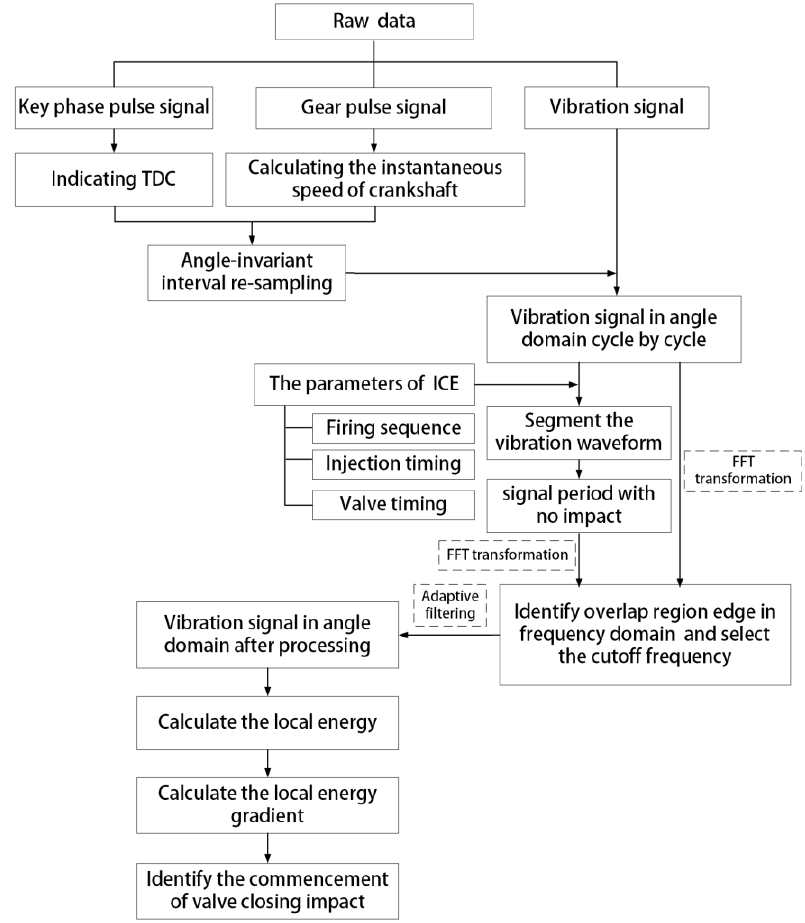
Figure 16. The procedures of the proposed method.